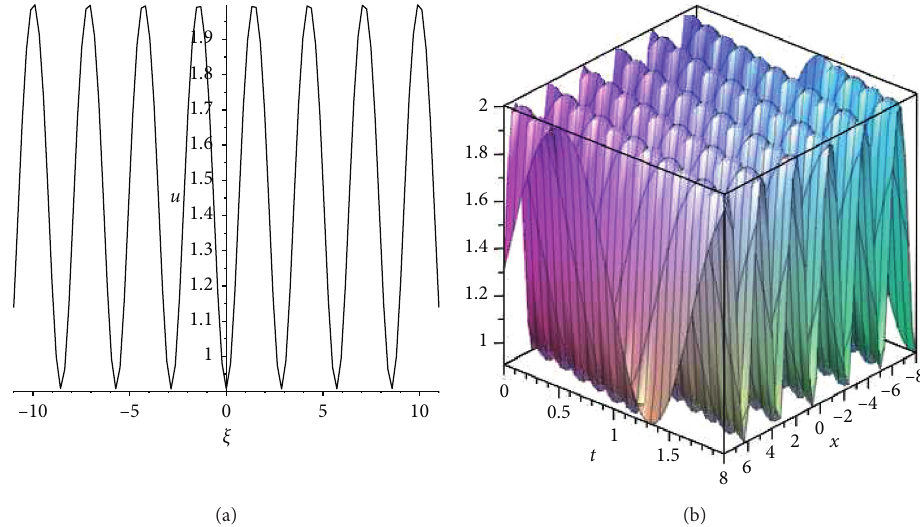
Figure 2: Periodic wave of (9) and exact periodic wave solutions of (2) when c � 0 . 2 and l �